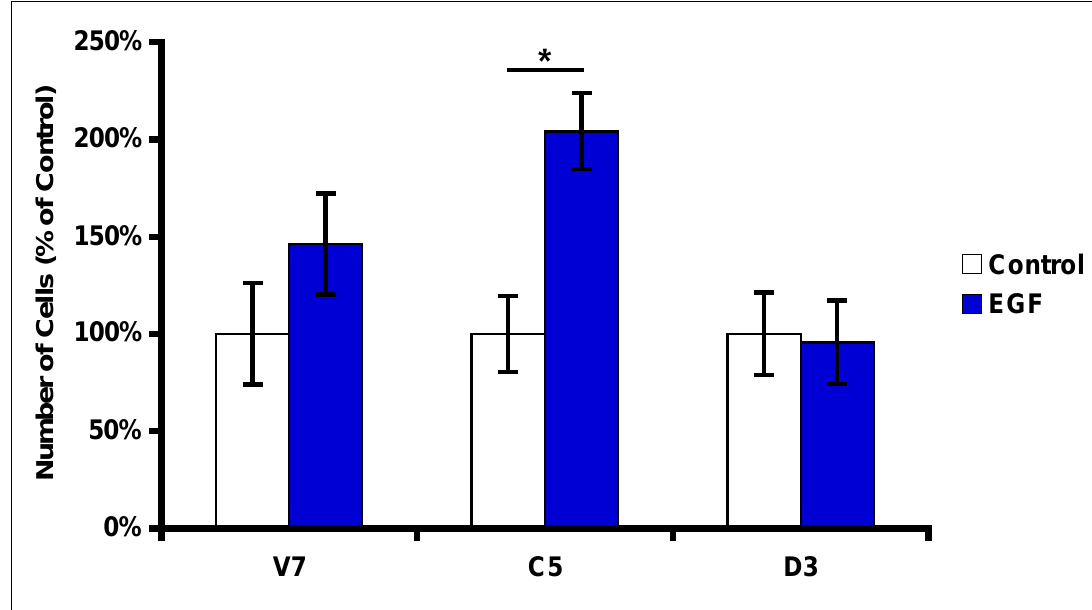
Figure 2. Effects of EGF treatment on EL4 cell proliferation. Equal numbers of EL4 cells (2 × 10 5 ) were plated and grown overnight. Cells were then serum starved for 24 hours. Serum-starved cells were treated with 10 nM EGF for 24 hours. Following treatment, viable cells were counted using hemacytometer. Cell numbers are presented as percent of control (without serum); each data point represents mean ± SD from three separate wells. Statistical significance was determined using t-test: * p <